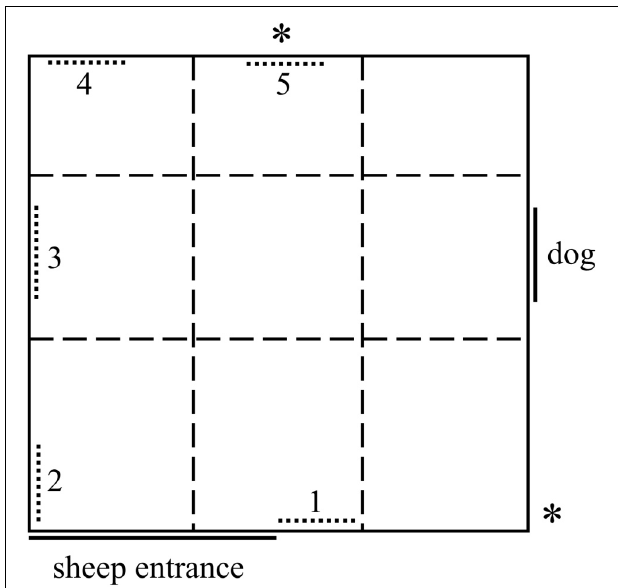
FIGURE 1 | Diagram of the attention bias test arena comprising a 4 m × 4.2 m yard with opaque 1.8 m high walls. A dog was visible for the first 3 s of the test, then the window was covered. The numbered, dotted lines represent potential locations of positive stimuli during the pilot study. Only position 3 was used during the main trial. “ ∗ ” Denotes the positions of two cameras. Dashed lines represent a grid overlaid on video footage